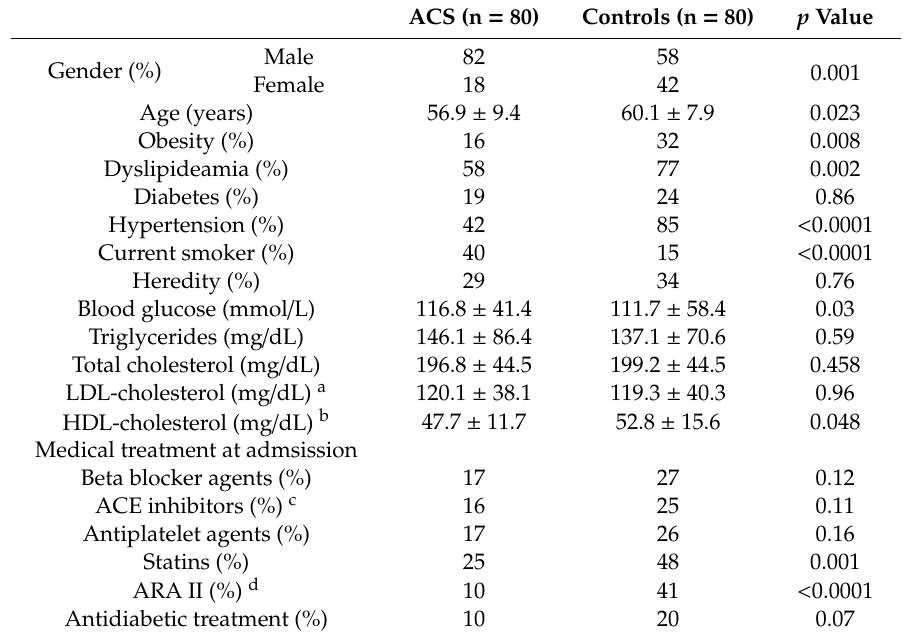
Table 1. Baseline characteristics of the acute coronary syndrome (ACS) and control participants.